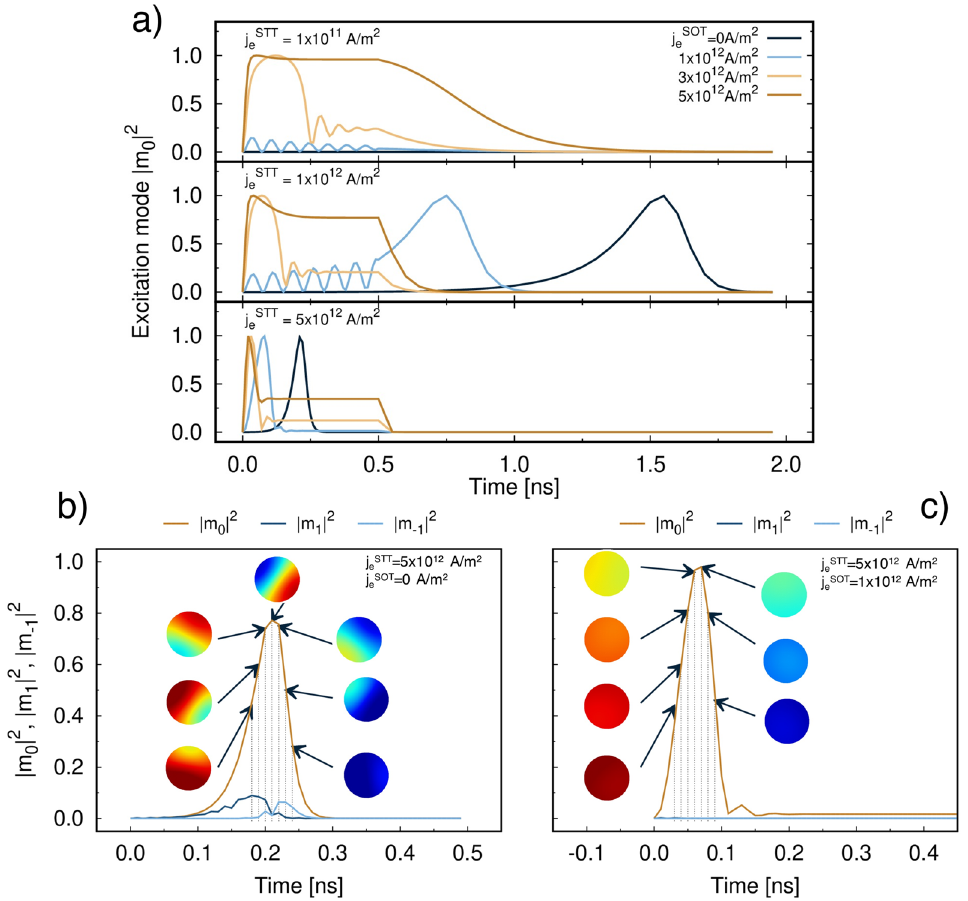
Figure 6. ( a ) Calculated amplitudes of the coherent excitation mode m 0 of the free layer of a 20 nm MTJ as a function of j SOT e for different j STT e and A F = 0.5 A D . ( b ) and ( c ) show the calculated amplitudes of m 0 , m 1 (vortex) and m − 1 (antivortex) modes of a 30 nm MTJ FL for A F = 0.5 A D , j STT e = 1 × 10 12 Am − 2 and j SOT e = 0 , 1 × 10 12 Am − 2 , respectively. Insets show snapshots of the z -component of the magnetisation with palette blue (+ 1), green (0), red (−